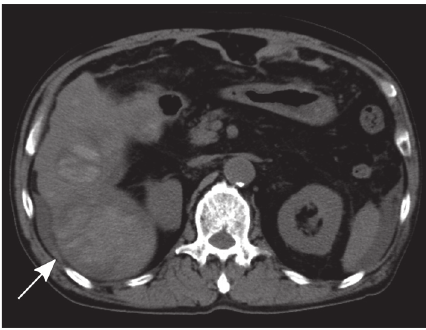
Figure 3: Nonenhanced computed tomography image. Perilesional blood was also observed near the hepatic tumor in the right lobe of the liver that was considered to indicate rupture of the HCC